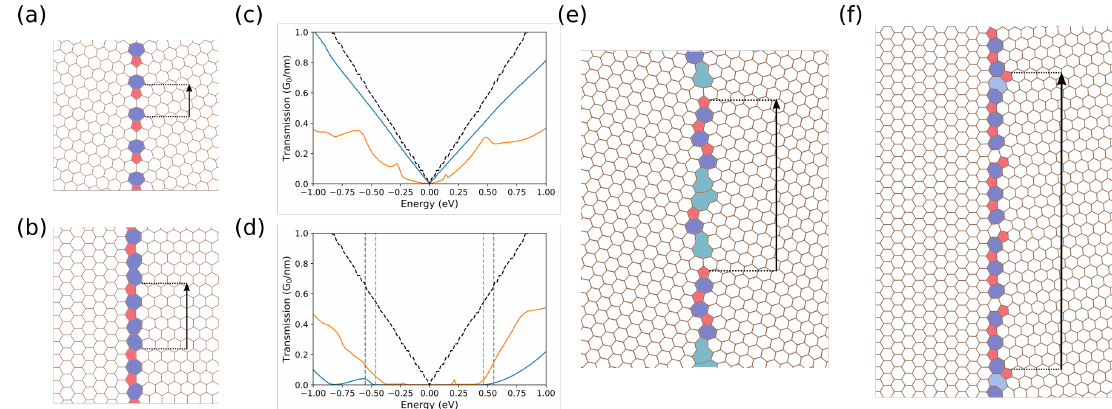
Figure 1. Electronic transport through graphene grain boundaries (GBs). Atomic structures of ( a ) the ( 2,1 ) | ( 2,1 ) class-I GB, ( b ) the ( 5,0 ) | ( 3,3 ) class-II GB, ( e ) the ( 11,3 ) | ( 10,5 ) class-I GB and ( f ) the ( 24,0 ) | ( 16,12 ) class-II GB. The zero-bias conductances are given in ( c , d ) for class-I and class-II systems, respectively. Conductances through the smallest (blue lines) and largest (orange lines) GBs are compared to pristine graphene (black dashed lines). Reprinted and adapted with permission from reference